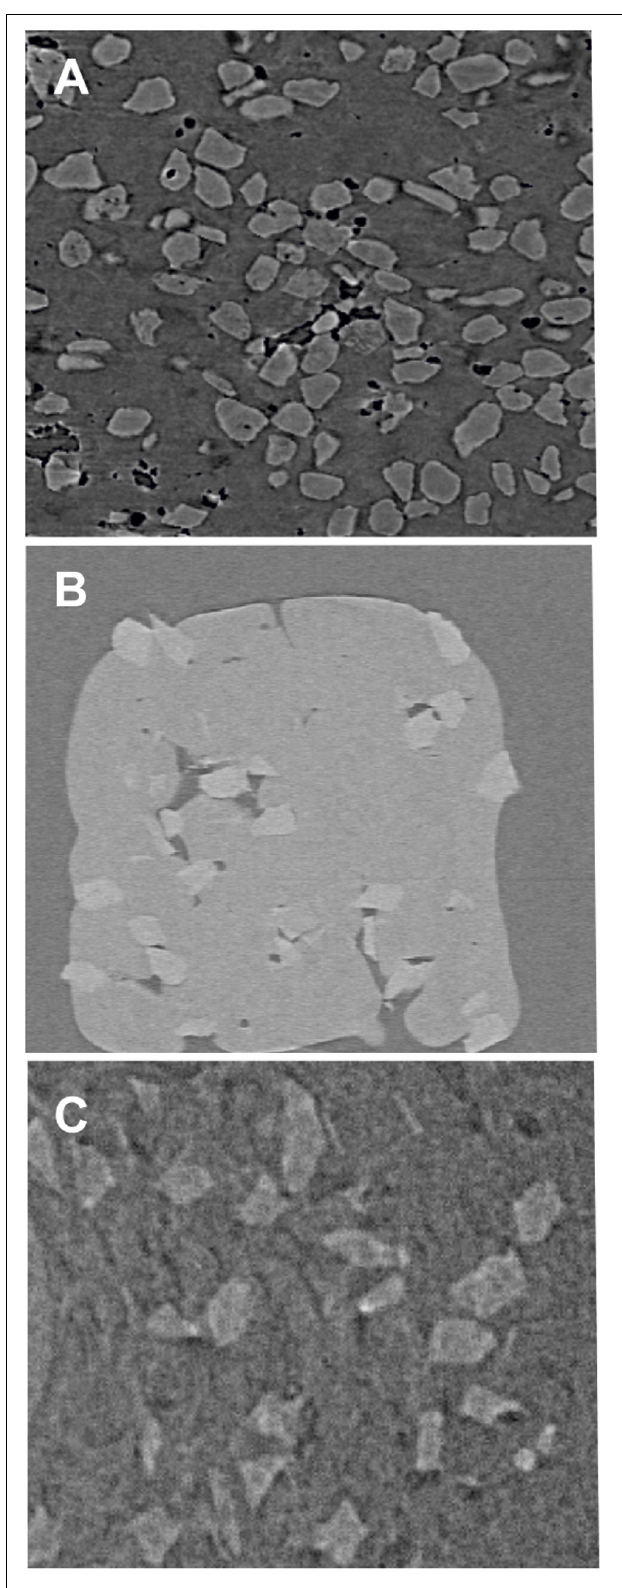
FIGURE 2 | Two-dimensional slices through 3D datasets showing the contrast between (A) rutile in borosilicate (filtered pink beam, SLS-TOMCAT, max energy ∼ 40 keV), (B) olivine in the borosilicate (DLS-i12-JEEP, monochromatic beam 53 keV), and (C) olivine in Canon N2700000 viscosity standard mineral oil (DLS-i12-JEEP, monochromatic beam 53 keV). The low contrast between olivine and borosilicate (shown in B ) makes data processing and quantitative analysis extremely challenging when working at short detector distances (minimizing phase contrast to allow accurate rendering of thin bubble wall films). Experiments that have used quartz, wollastonite and feldspars in synthesized haplogranitic and dioritic melts have even lower contrasts, and the particles cannot be observed even with the lower energy at SLS-TOMCAT. The crystals in all three samples are in the 90–180 µ m size fraction. Red line shows X-ray beam